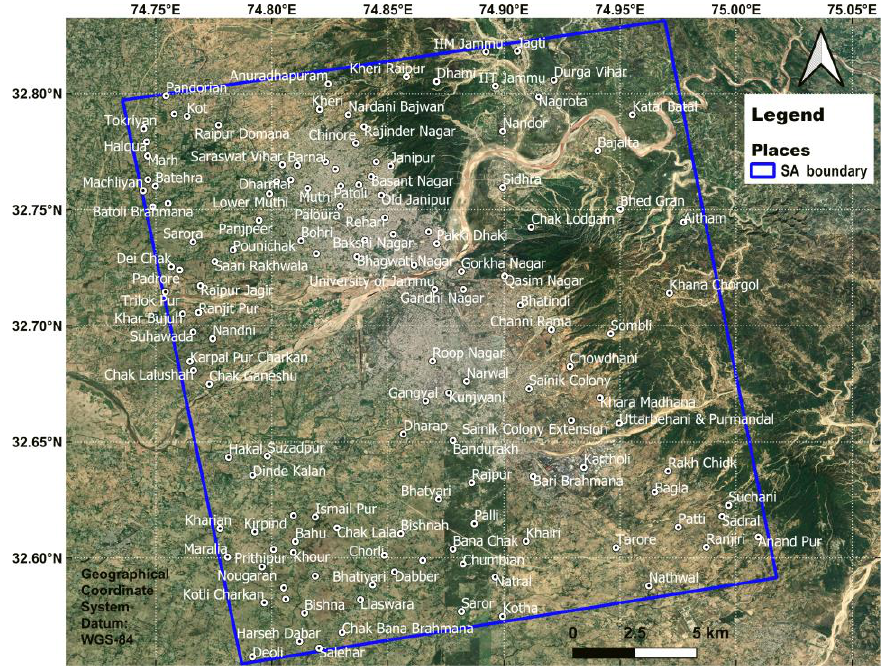
Figure 2. Geography Bounds of the study area are illustrated with a Google base map layer.